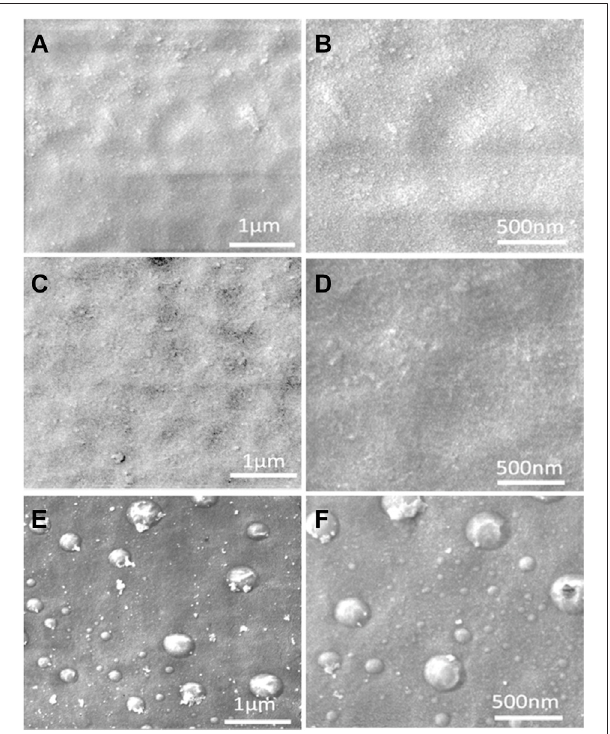
FIGURE 3 | SEM images of the coatings: (A) WEP (control, without graphene oxide) with scale 1 µm, (B) WEP (control, without graphene oxide) withscale500 nm, (C) GOWE-0.1(0.1 wt%grapheneoxide) withscale 1 µm, (D) , GOWE-0.1 (0.1 wt% graphene oxide) with scale 500 nm, (E) GOWE-0.5(0.5wt%grapheneoxide)withscale1 µm,and (F) GOWE-0.5(0.5 wt% graphene oxide) with scale 500